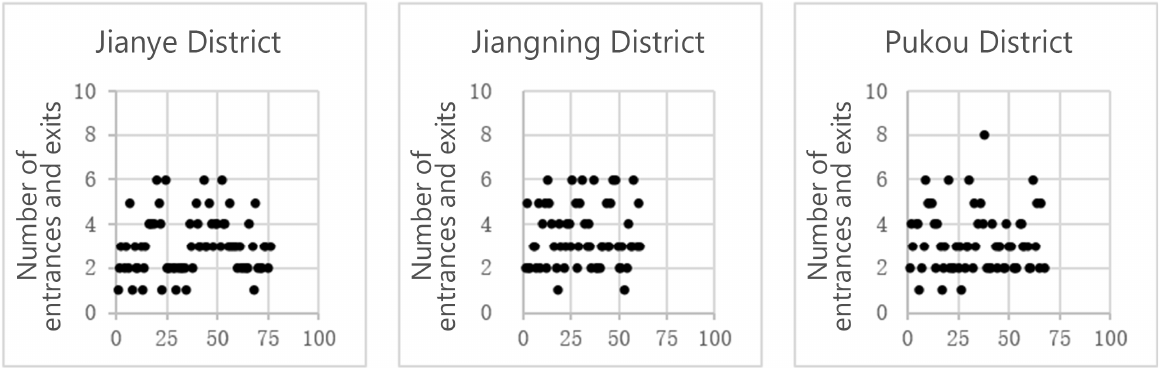
Figure 3. Numbers of entrances and exits of 204 residential areas in Jiangning, Jianye, and Pukou District.